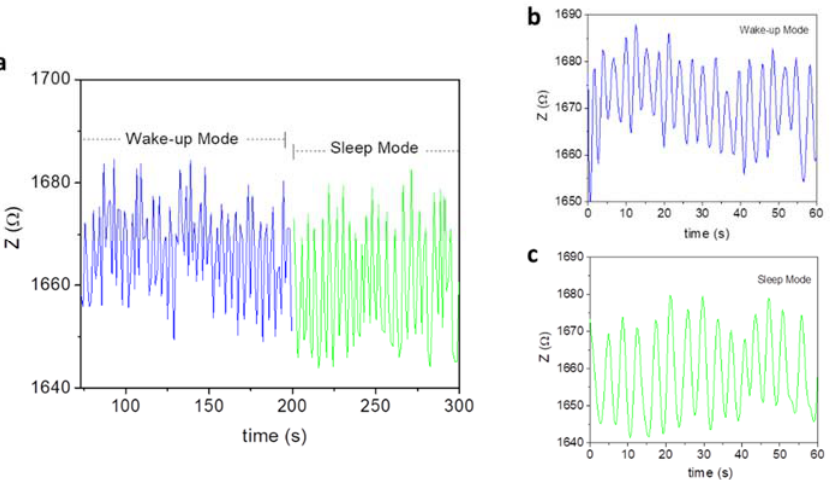
Figure 8. ( a ) Breathing patterns of Subject 3 in both wake and sleep modes. An obvious transition from the wake to the sleep mode was observed. ( b , c ) show the wake-up and sleep breathing patterns per 1 min.